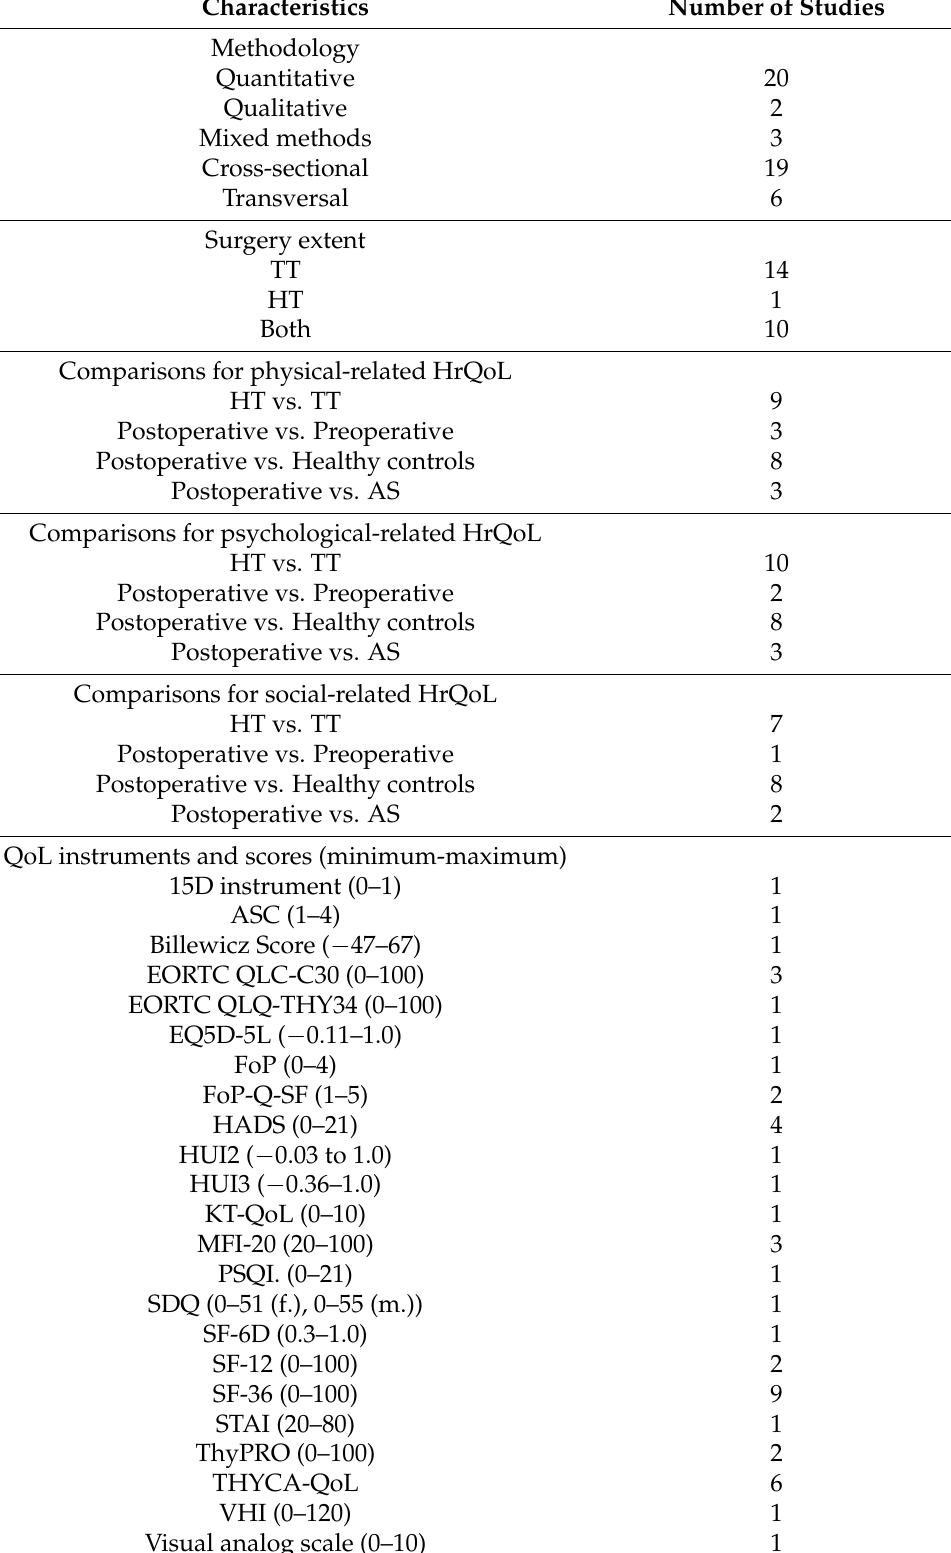
Table 1. Characteristics of included